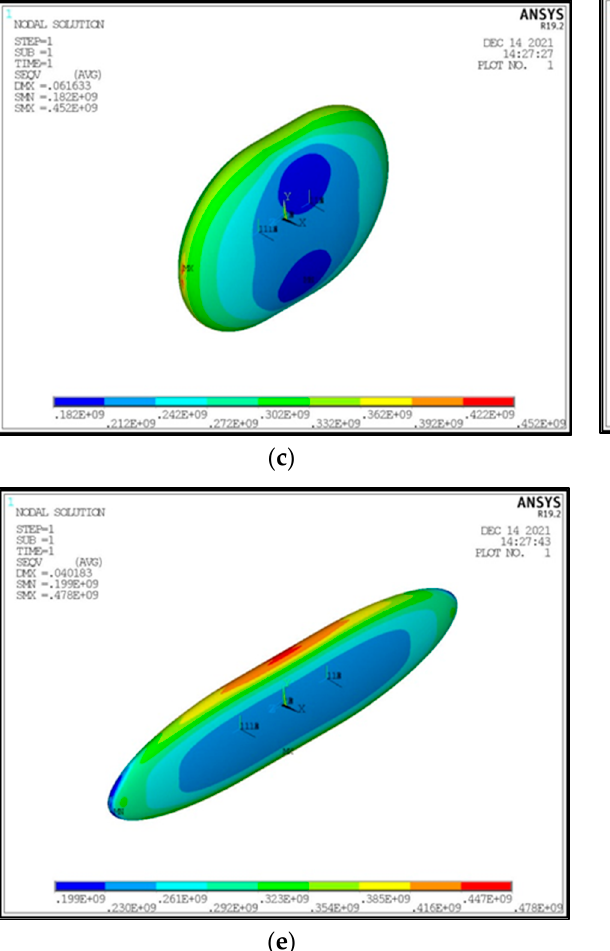
Figure 23. Characteristic tank case with transition of the maximum Von Mises stress between different tank regions ( λ = 0.25, φ = 0.333, ψ = 0.333 ( a ), 0.666 ( b ), 1 ( c ), 1.5 ( d ), 3 ( e )).